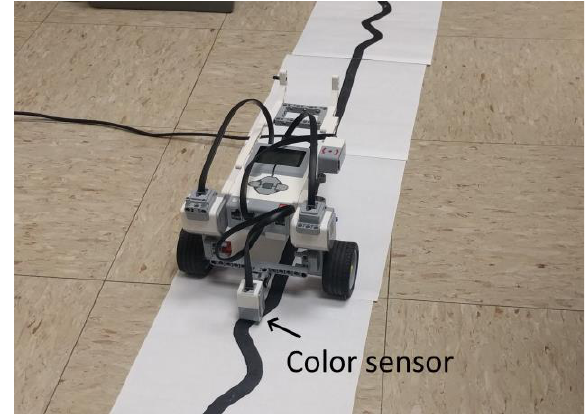
Fig. 5. An example of a model car tracking a line as a robotics